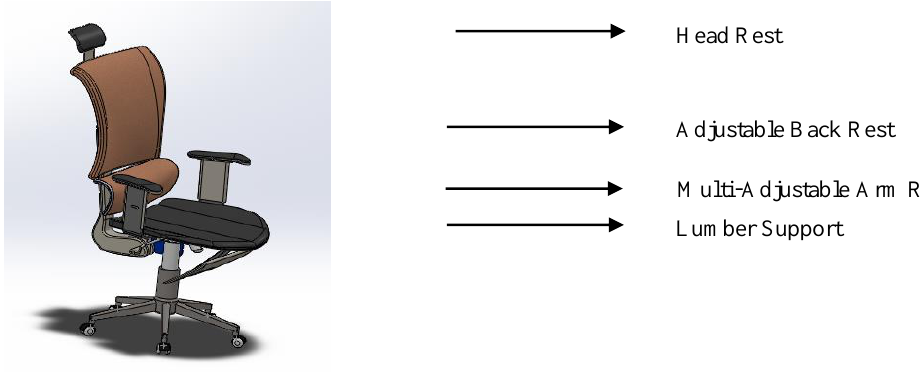
Figure 3. Design chair in 3D side view [designed by solidworks 2017 x64 edition].